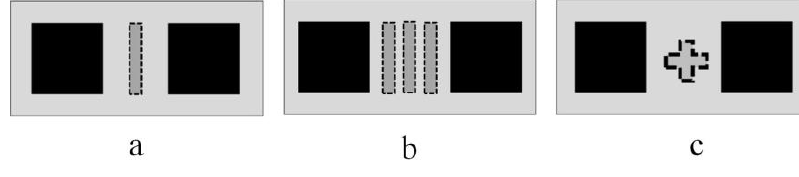
Fig. 3. Defected ground plane antennas: a – one slot, b – three slots, c - crossed slots Frequency dependence of coupling coefficient amount for the antenna with three slots (Fig. 3, b) is shown in Fig. 4 (curve